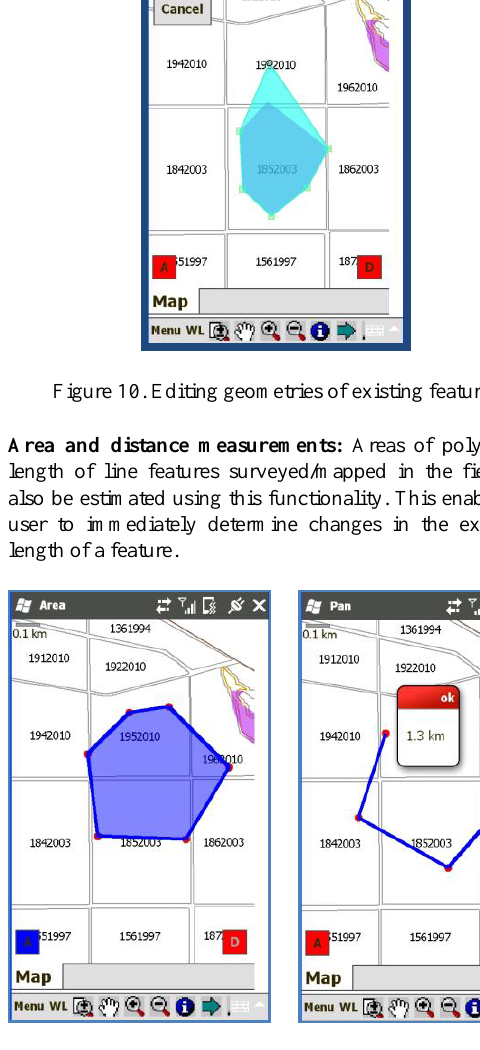
Figure 11. Area and distance measurement functions 